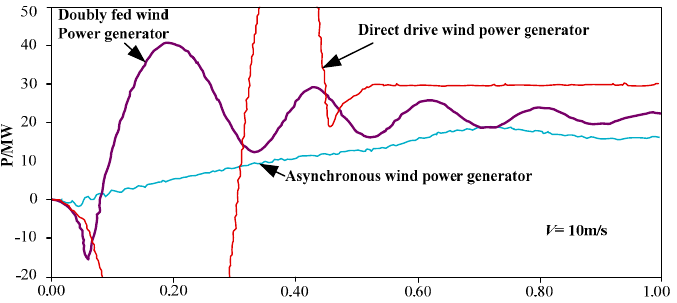
Figure 3. Power generation by different type of wind turbine during the same wind speed.